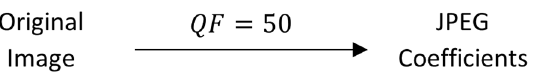
Figure 9. The “single-compressed” image.